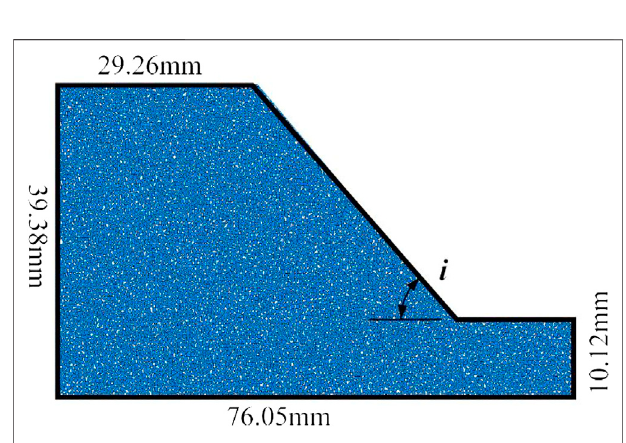
FIGURE 3 | Slope model ( i (cid:2) 45 °